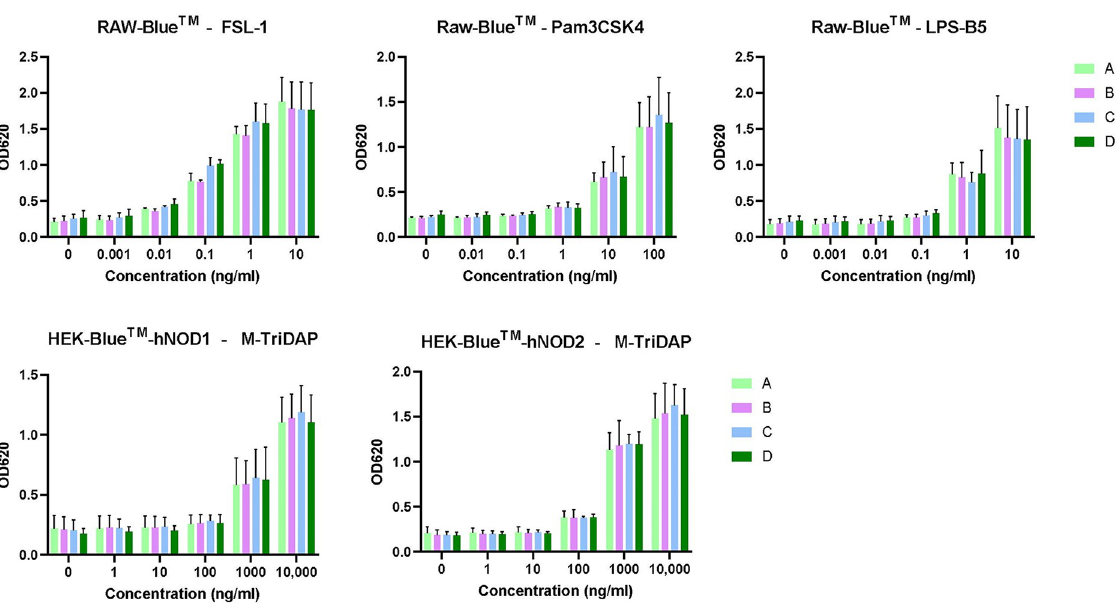
Fig 4. Innate immunogenicity masking assessment assay. Each bar represents mean ± stdev of 2–3 times of independent